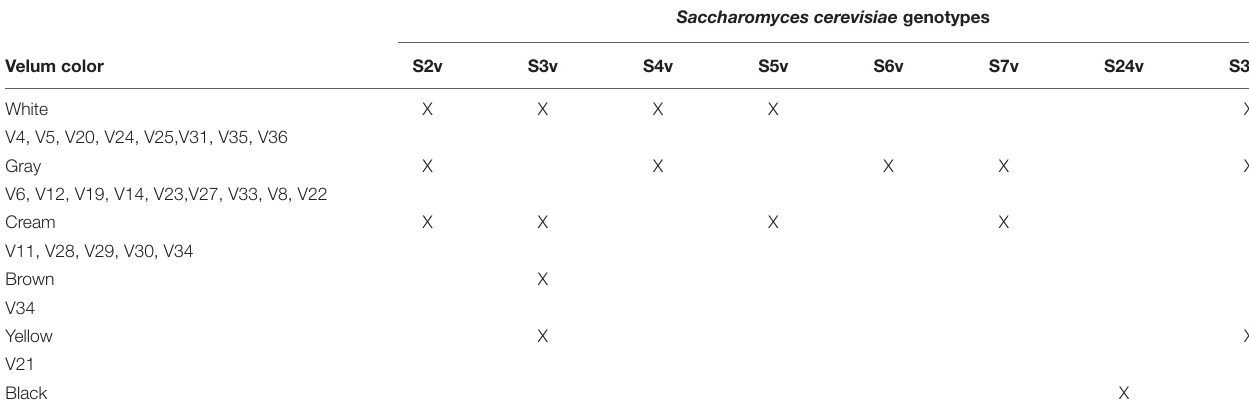
TABLE 5 | Example of different Saccharomyces cerevisiae genotypes isolated in velum with different